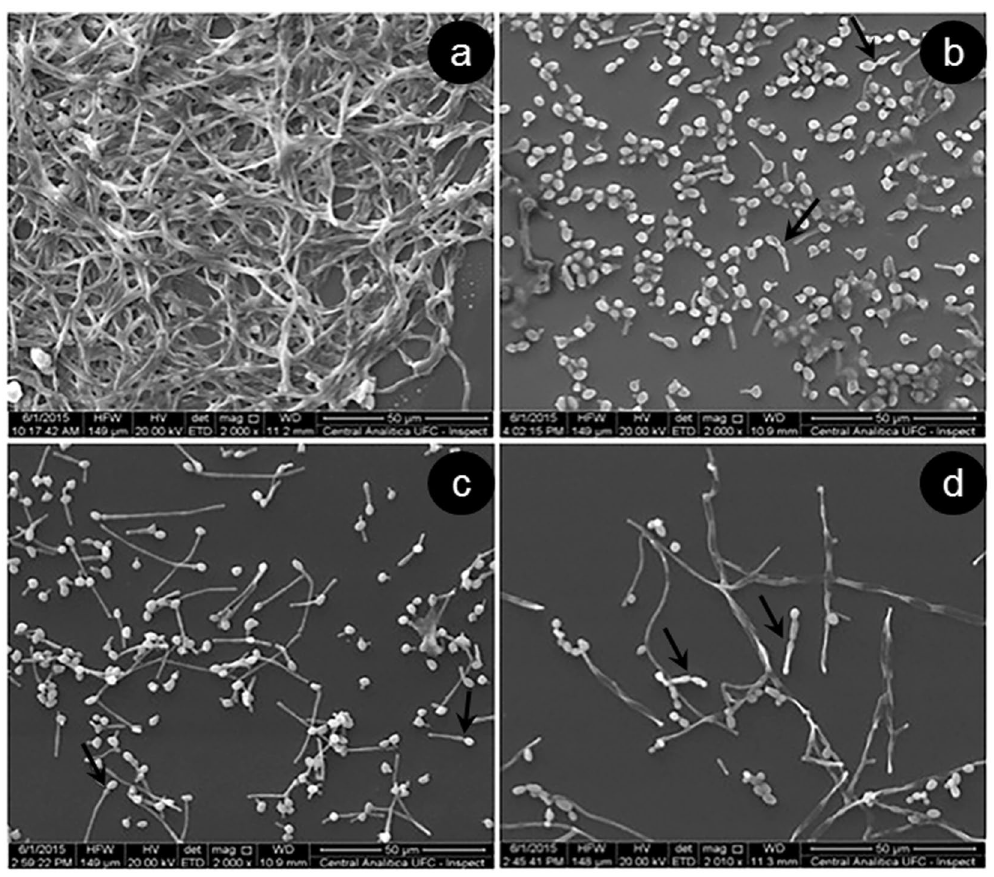
Figure 3. Scanning electron microscopy of C. albicans ATCC 10.2.31 growing biofilms after 48 h incubation left untreated ( a ) or treated with 0.1, 10, or 20 ng/mL mTNF ( b , c , d ), respectively. Arrows indicate pseudohyphae (Original x2000).